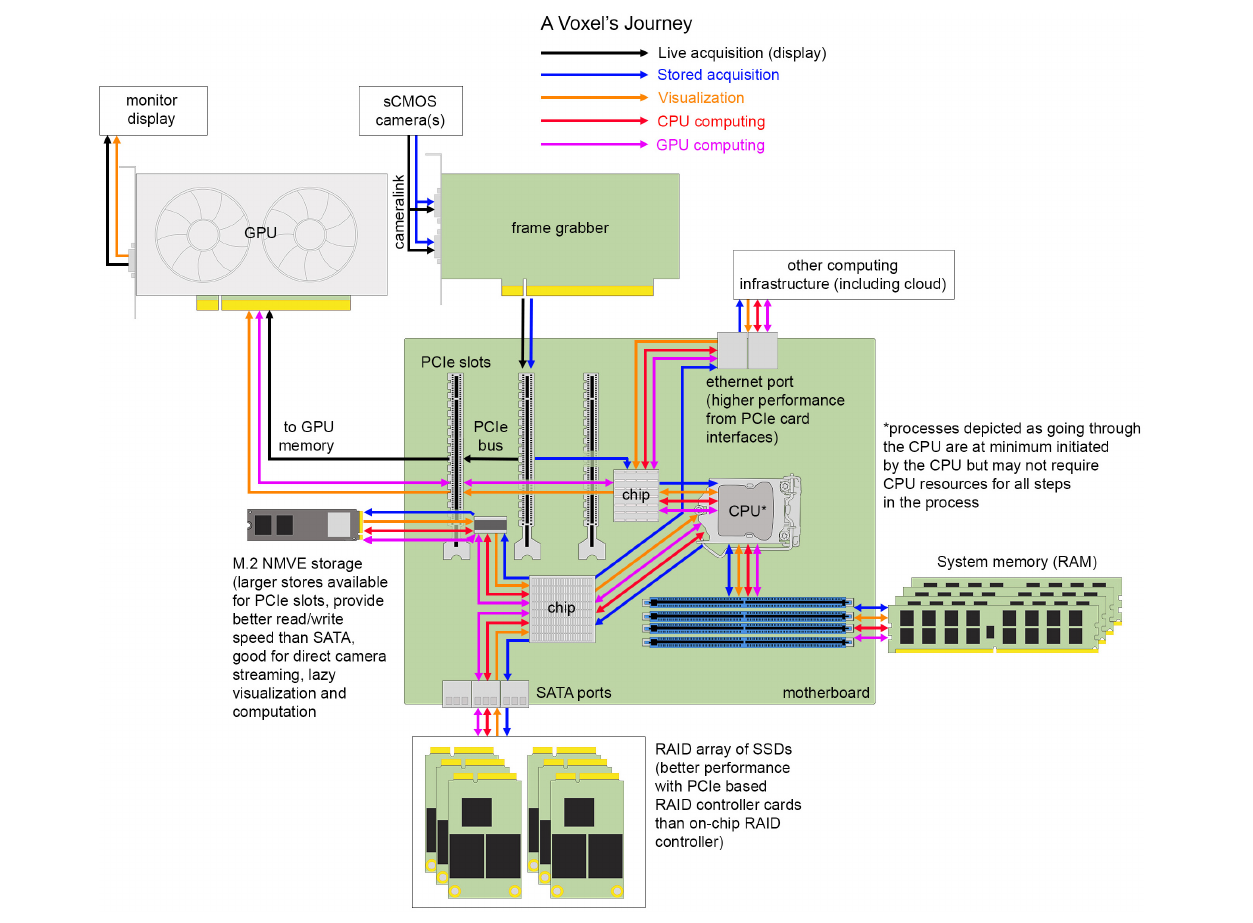
FIGURE 4 | The journey of a voxel. Hardware components and interfaces for transferring data between them on one example of a typical image analysis workstation.